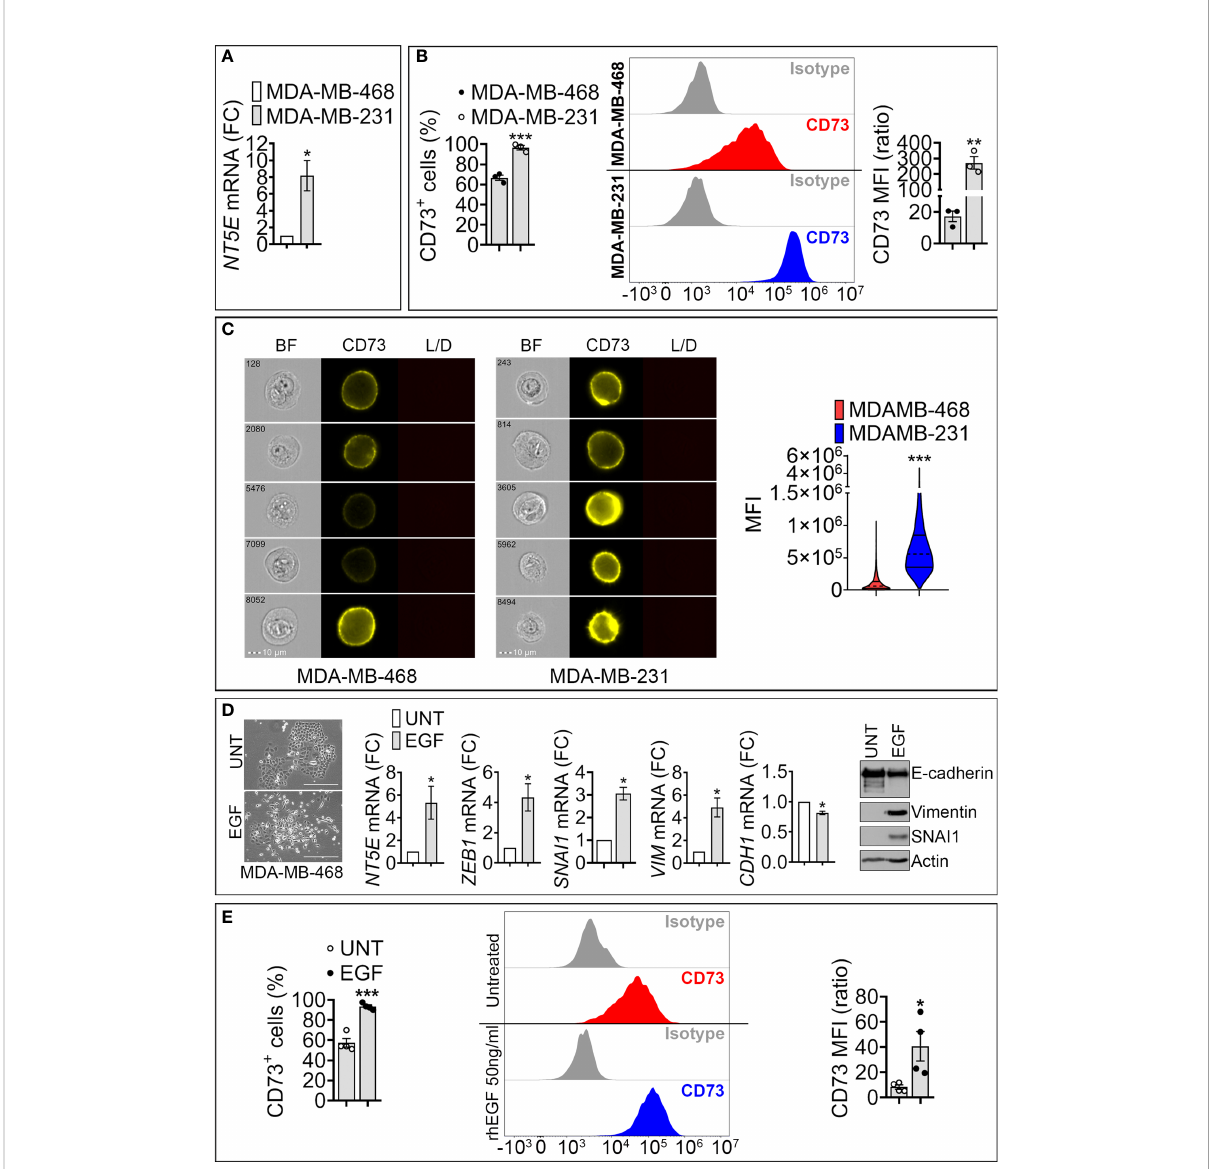
FIGURE 1 Expression of NT5E /CD73 mRNA and protein in mesenchymal-like MDA-MB-231 and epithelial like MDA-MB-468 TNBC cells. (A) RT-qPCR measurement of NT5E mRNA in mesenchymal-like MDA-MB-231 and epithelial-like MDA-MB-468 TNBC cell lines. NT5E expression was calculated relative to MDA-MB-468 cells. Bars represent means from four independent experiments ± SEM; * P < 0.05 calculated by Mann Whitney. (B) Flow cytometry analysis of cell surface CD73 in TNBC cells. Left panel: percentage of CD73-positive (CD73 + ) cells; Middle panel : representative FACS histograms of indicated cells stained with control isotype or anti-CD73 antibody. Right panel: mean fl uorescence intensity (MFI) of cell surface CD73 in MDA-MB-468 and MDA-MB-231 cells. Bars represent means from three independent experiments ± SEM, ** P < 0.01, *** P < 0.001 calculated by unpaired t-test. (C) CD73 cell surface expression in MDA-MB-468 and MDA-MB-231 cells acquired by imaging cytometry . Left panels: representative images for each cell line acquired on bright fi eld (BF), CD73-PE, and live/dead (L/D) channels. The scale bar and event number are shown. Right panel: Violin plot quanti fi cation of CD73 mean fl uorescence intensity (MFI) acquired by imaging cytometry in MDA-MB-468 and MDA-MB-231 cells. Results are the average of 10 4 acquisitions, ***P < 0.001 by unpaired t-test. (D) Left panels: Morphology of untreated (UNT)- and EGF (EGF)-treated MDA-MB-468 cells. Bar: 300 m m. Middle panels: mRNA expression of CD73 and EMT markers (SNAI1, ZEB1, VIM and CDH1) in MDA-MB-468 cells treated with rhEGF (50ng/ml for 6 days). The expression level of each gene in treated (EGF) cells was calculated relative to untreated (UNT) cells. Bars represent means from four independent experiments ± SEM; * P < 0.05 calculated by Mann Whitney. Right panel : Representative Western-blot showing the protein expression of E-cadherin, SNAI1, Vimentin in (UNT)- and EGF (EGF)-treated MDA-MB-468 cells. Actin was used as a loading control. (E) . Flow cytometry quanti fi cation of surface CD73. Left panel: Percentage of CD73 positive MDA-MB-468 cells treated as described in (D) . Middle panel : representative FACS histograms of untreated or rhEGF-treated MDA-MB-468 cells stained with isotype or anti – CD73 antibody. Right panel: Mean fl uorescence intensity (MFI) of cell surface CD73 in MDA-MB-468 treated as described in (D) . Bars represent means from four independent experiments ± SEM; * P < 0.05, and *** P < 0.001 are calculated by unpaired